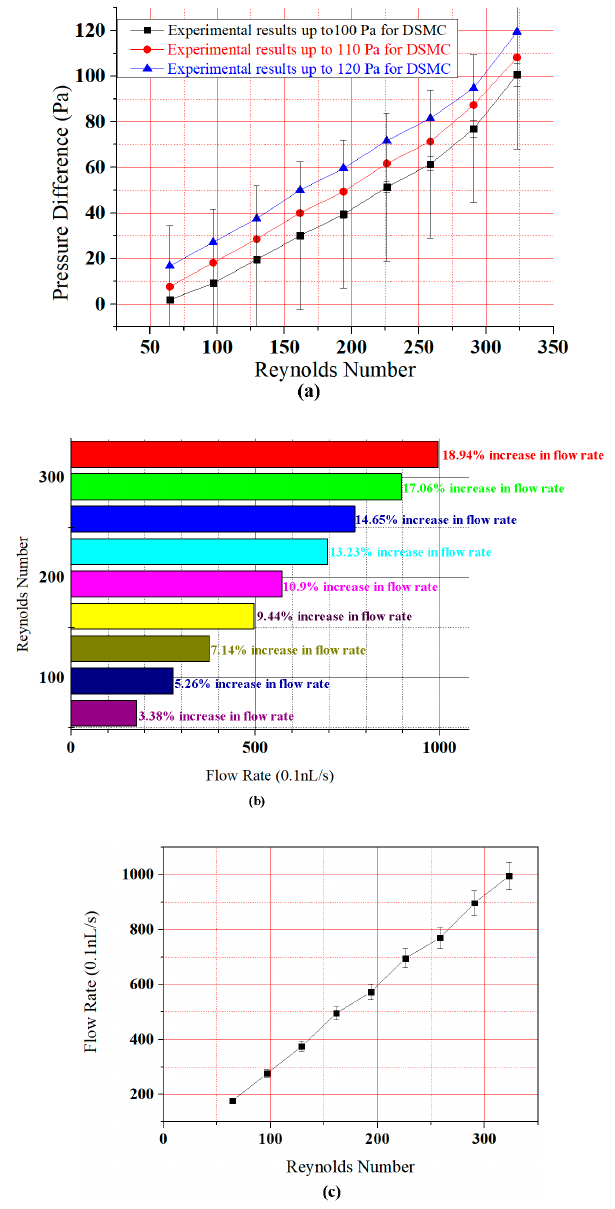
Figure 9. Experimental graphical results ( a ) Graph relating Reynolds number and pressure difference with error bars; ( b ) bar graph between Flow rate and Reynolds number for DSMC; ( c ) graph between Flow rate and Reynolds number with error bar.